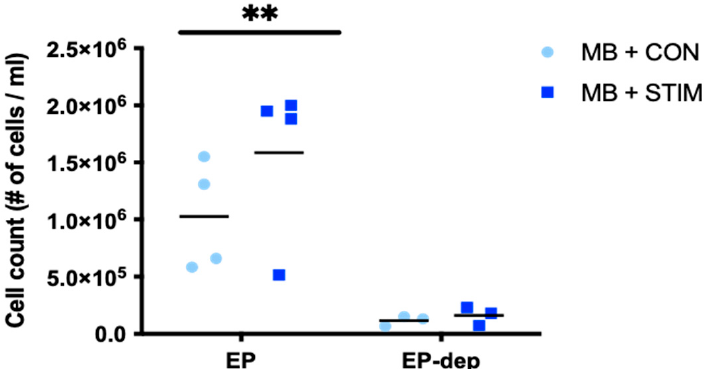
Figure 7. Cell count in myoblasts (MB) treated with EPs or EP-depleted media from CON vs. STIM myotubes. 90,000 cells/well were seeded in 6-well plates and left to adhere for 4 h. Cells were treated with 13 µg/well EPs (isolated using Total Exosome Isolation Reagent (ThermoFisher, Waltham, MA, USA) or with EP-depleted media (EP-dep, 1 mL) conditions from non-stimulated control (CON) vs. acutely stimulated (STIM) myotubes for 72 h. Total number of cells were counted using a haemocytometer and expressed per mL of media. Cell count was ~90% lower in myoblasts treated with EP-dep conditions from either CON or STIM myotubes (** p < 0.01, main effect of EP vs. EP-dep, n = 3–4).